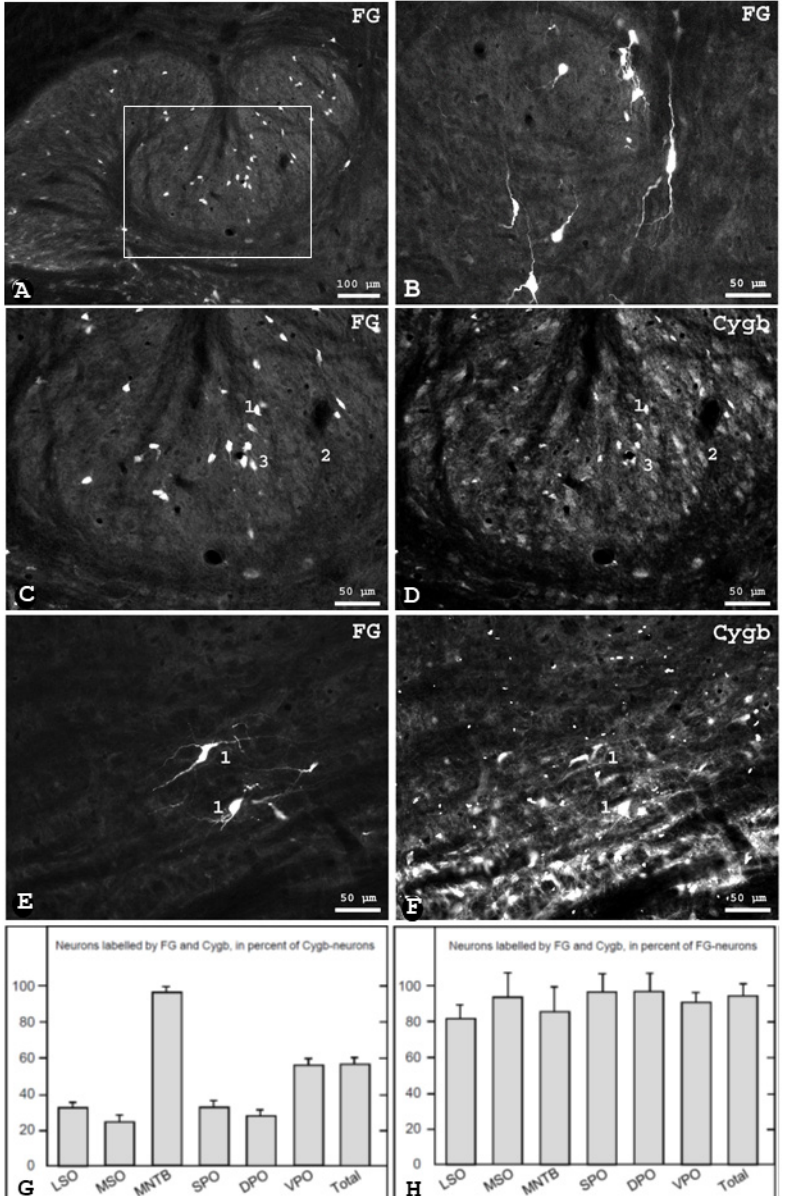
Figure 2. Labelled neurons in the ipsilateral superior olivary complex of the rat after injection of Fluorogold (FG, shown in A – C ) into the cochlea and retrograde axonal transport, combined with cytoglobin (Cygb) immunofluorescence, shown in ( D , F ). The boxed area in A is shown in ( C , D ), where many double-labelled cell bodies (exemplarily marked “1”), but also neurons solely labelled by Cygb (“2”) or FG (“3”), were observed. Large shell neurons identified by FG (“1”) are shown in ( B ), and in ( E ) belonging to a group of large Cygb-neurons in the VPO in ( F ). The Cygb distribution pattern was not affected by cochlear injection. ( A – F ) frontal plane, orientation: medial left, dorsal up. Abbreviations: see list. ( G ): olivocochlear neurons identified by FG in percent of Cygb neurons. ( H ): Cygb-neurons in percent of olivocochlear neurons (mean ± SD, n =